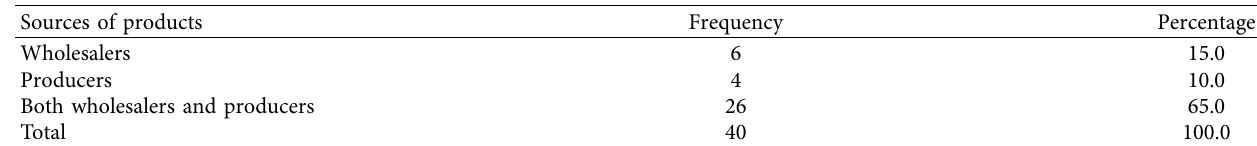
Table 3: Sources of the commodities.